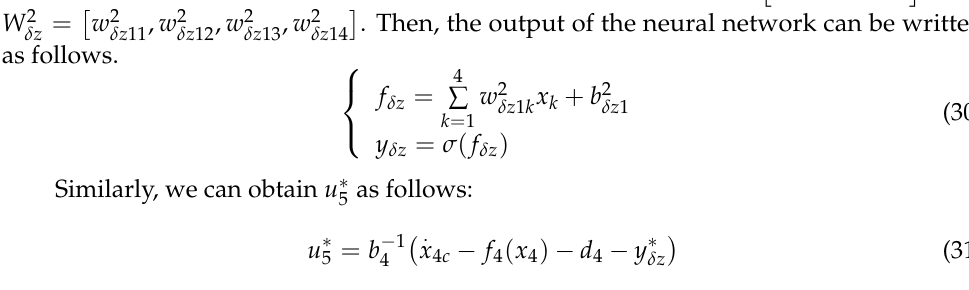
(cid:104) (cid:105) T . w zd , δ z , δ z , d 4 and